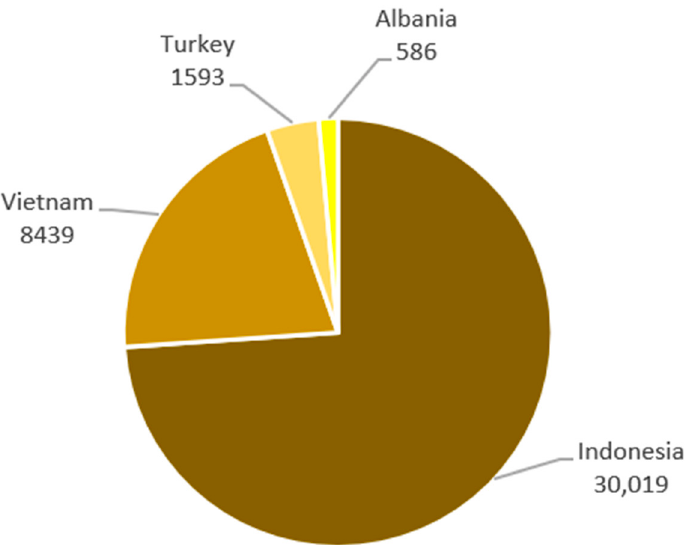
Figure 1. Suppliers for the EU’s frogs’ legs imports (rounded in tonnes), in the period 2010–2019 [4]. Indonesia, Turkey, and Albania source wild populations; Vietnam also farms species for the EU [8].